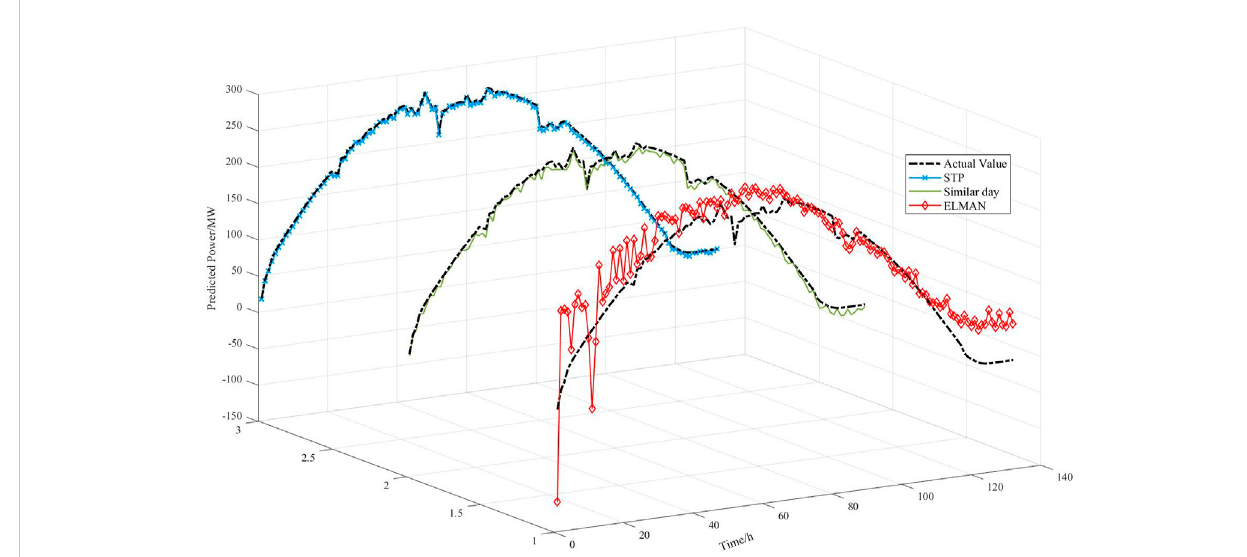
FIGURE 6 Simulation comparison of PV power prediction results by three models.